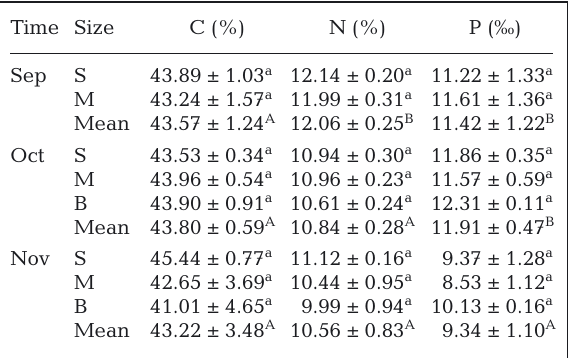
Table 2. Mean (±SD) biogenic element composition in bay scallop Argopecten irradians tissue. S: small size scallop; M: medium size; B: big size. Different lowercase letters in the same month indicate significant differences (p < 0.05). Dif- ferent uppercase letters among different months indicate significant differences (p < 0.05)